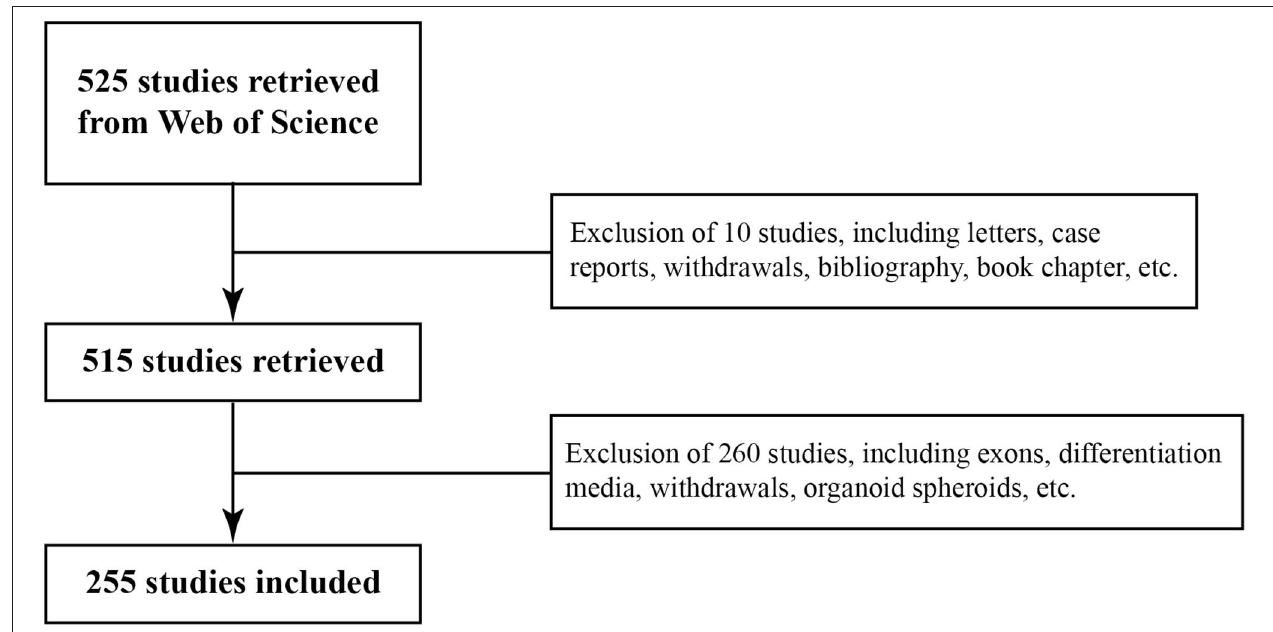
FIGURE 1 | Flow chart of the screening process for research on stem cell-derived extracellular vesicles (SC-EVs) for diabetes.